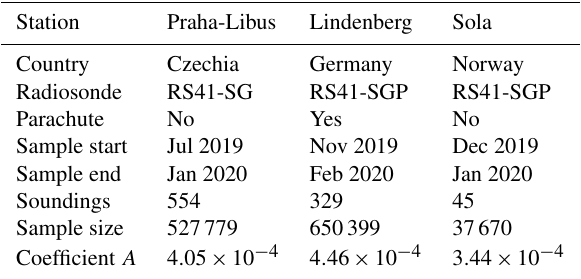
Table 3. Best estimate of the correction coefficient for different times of launch at Praha-Libus.